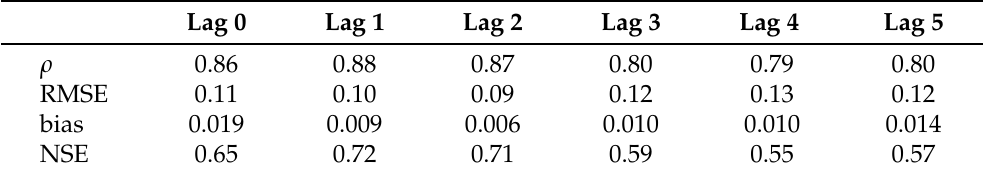
Table 2. Performance of Neural Network models where the dimension of the input feature space is stepwise increased by adding information from radar with different time